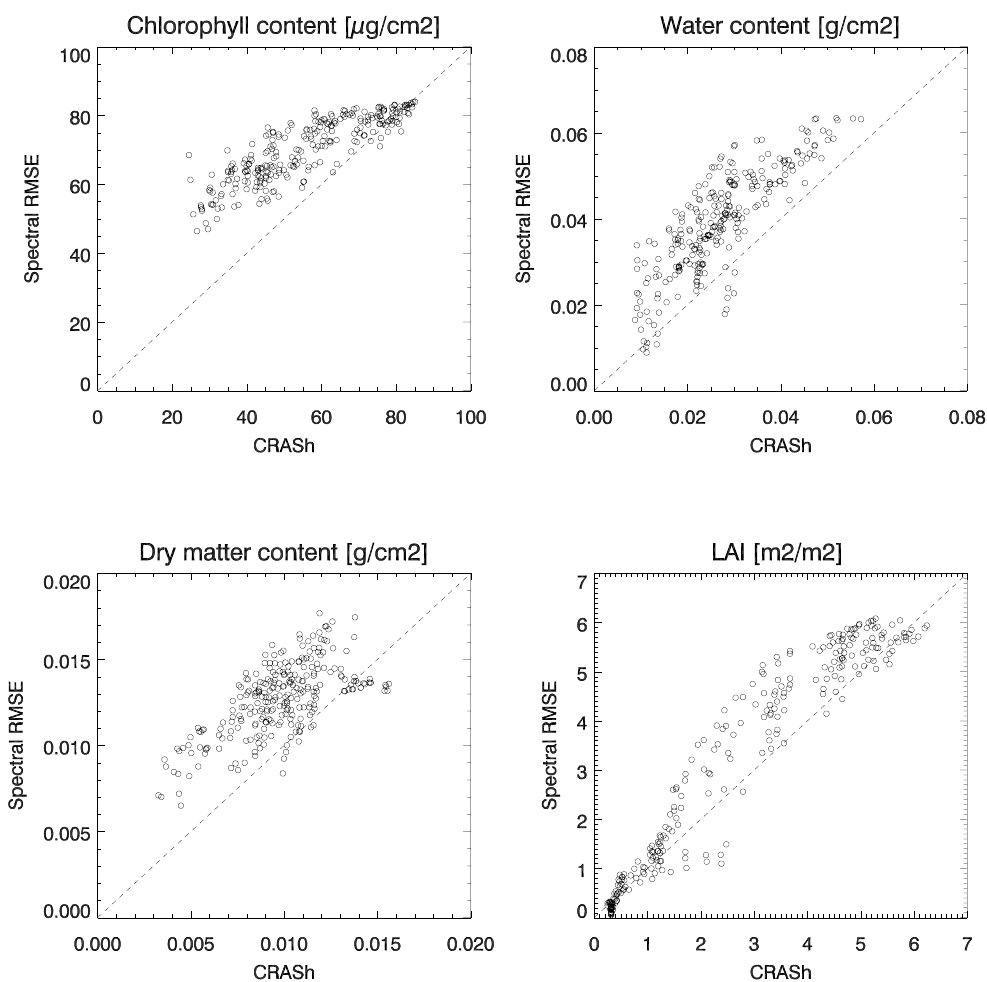
Figure 4. Inversion results of CRASh approach versus conventional spectral RMSE based